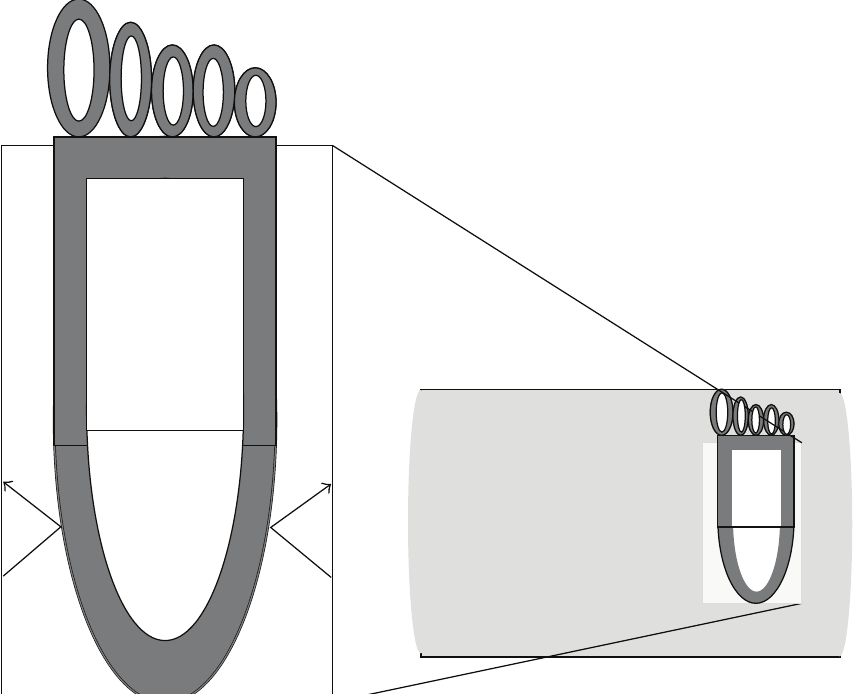
Figure 1: A schematic drawing of the DXL equipment and the placement of the foot. The black lines show how the laser beams are reflected at the surface of the skin, not at the calcaneal